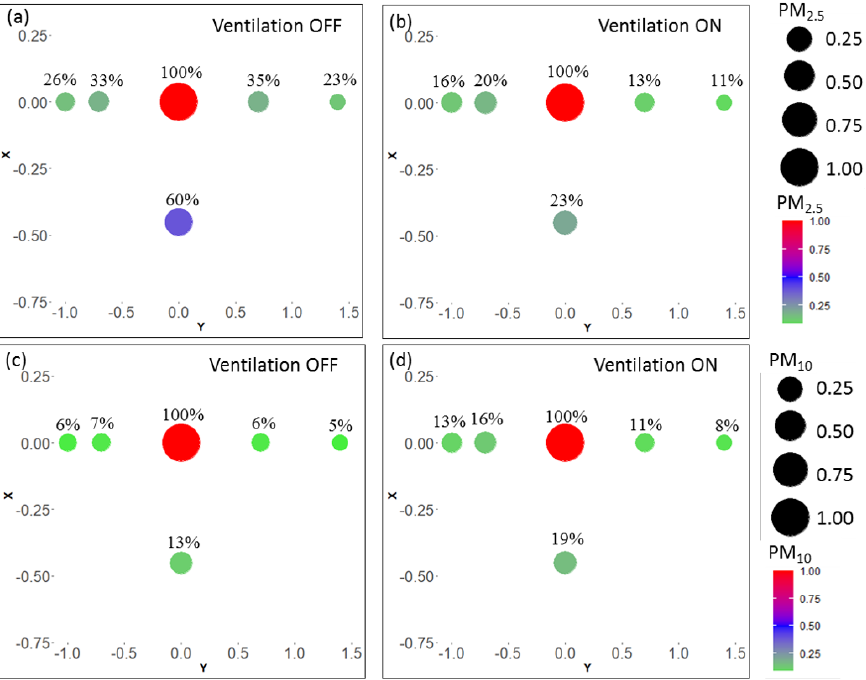
Figure 10. Spatial distribution of averaged normalised ( a , b ) fine and ( c , d ) coarse aerosol particle concentrations at each location under unventilated and ventilated